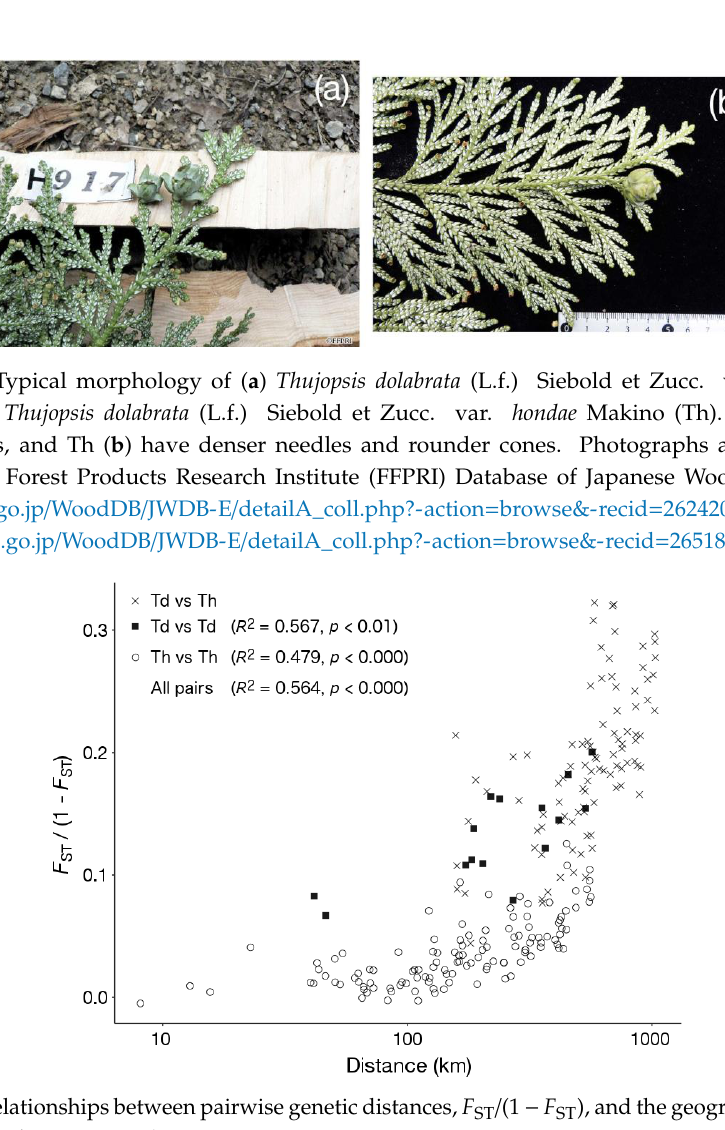
Figure A3. Relationships between the number of clusters (K) and the rate of the change in lnP(X|K) (Delta K ), based on STRUCTURE analysis.